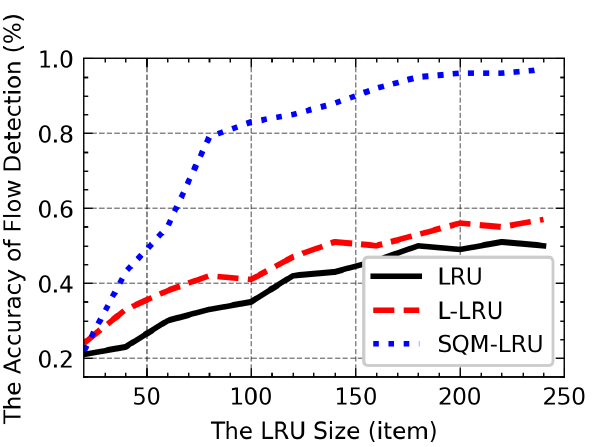
Figure 20. The influence of LRU size on Acc.